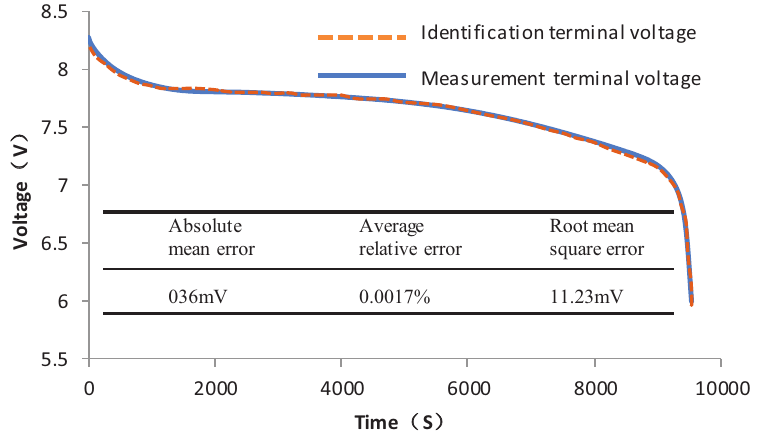
Figure 10. The online identification effect of terminal